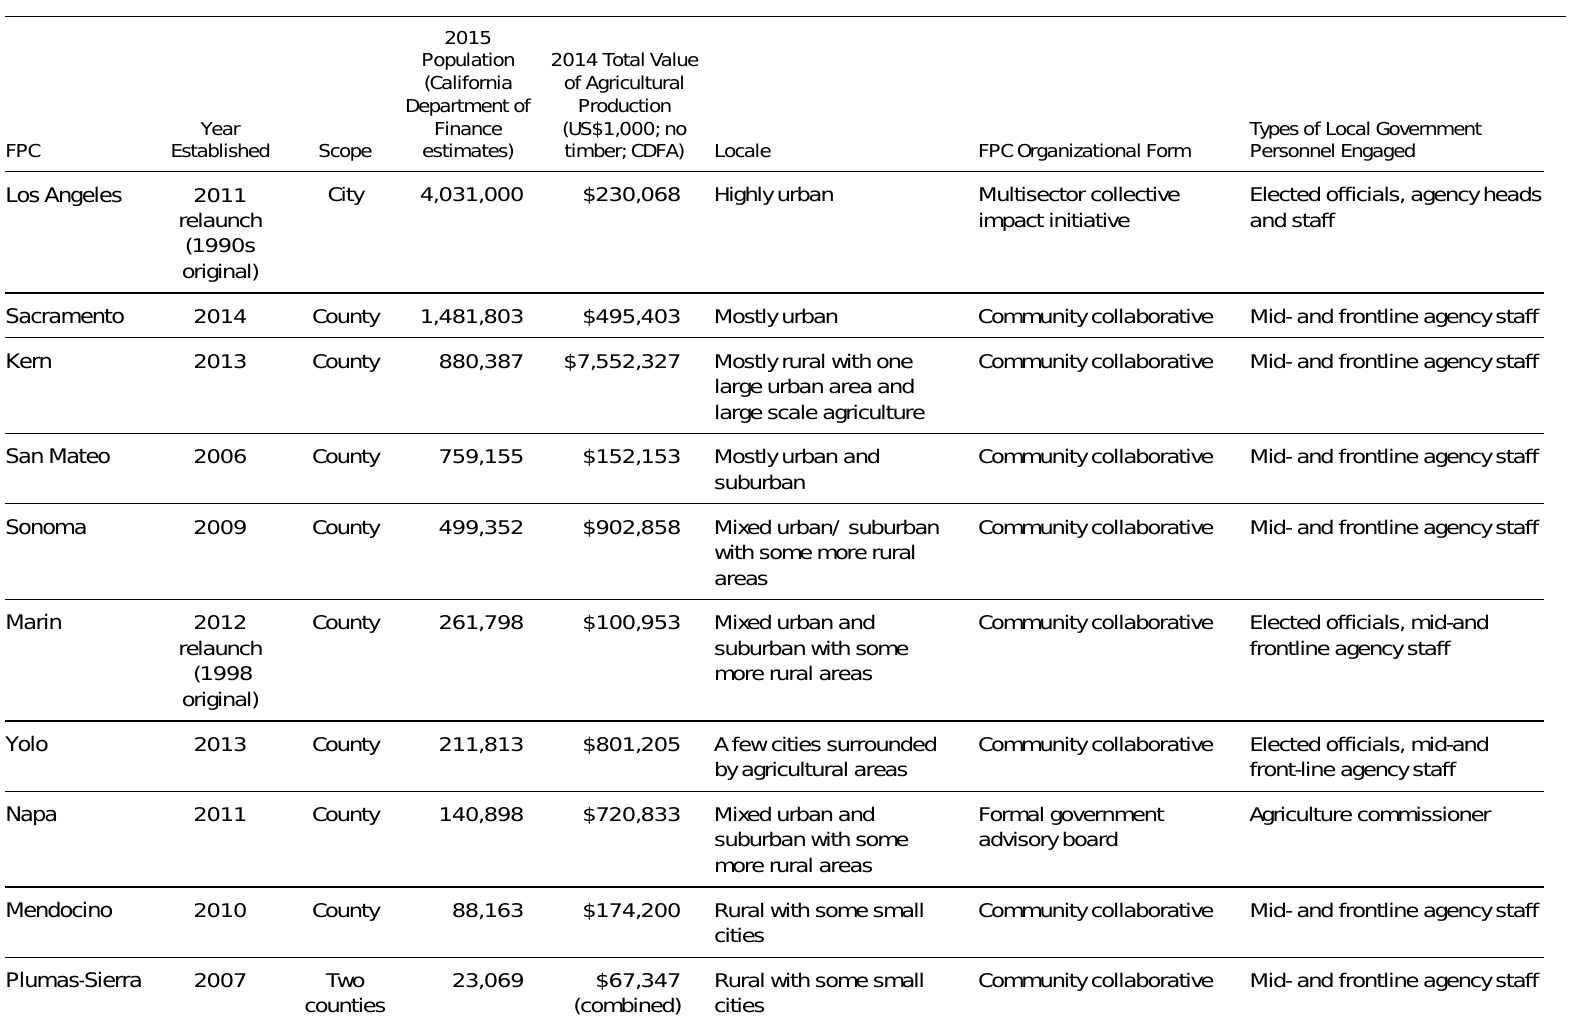
Table 1. Basic Comparisons of California FPCs in Sample (by descending size of population)